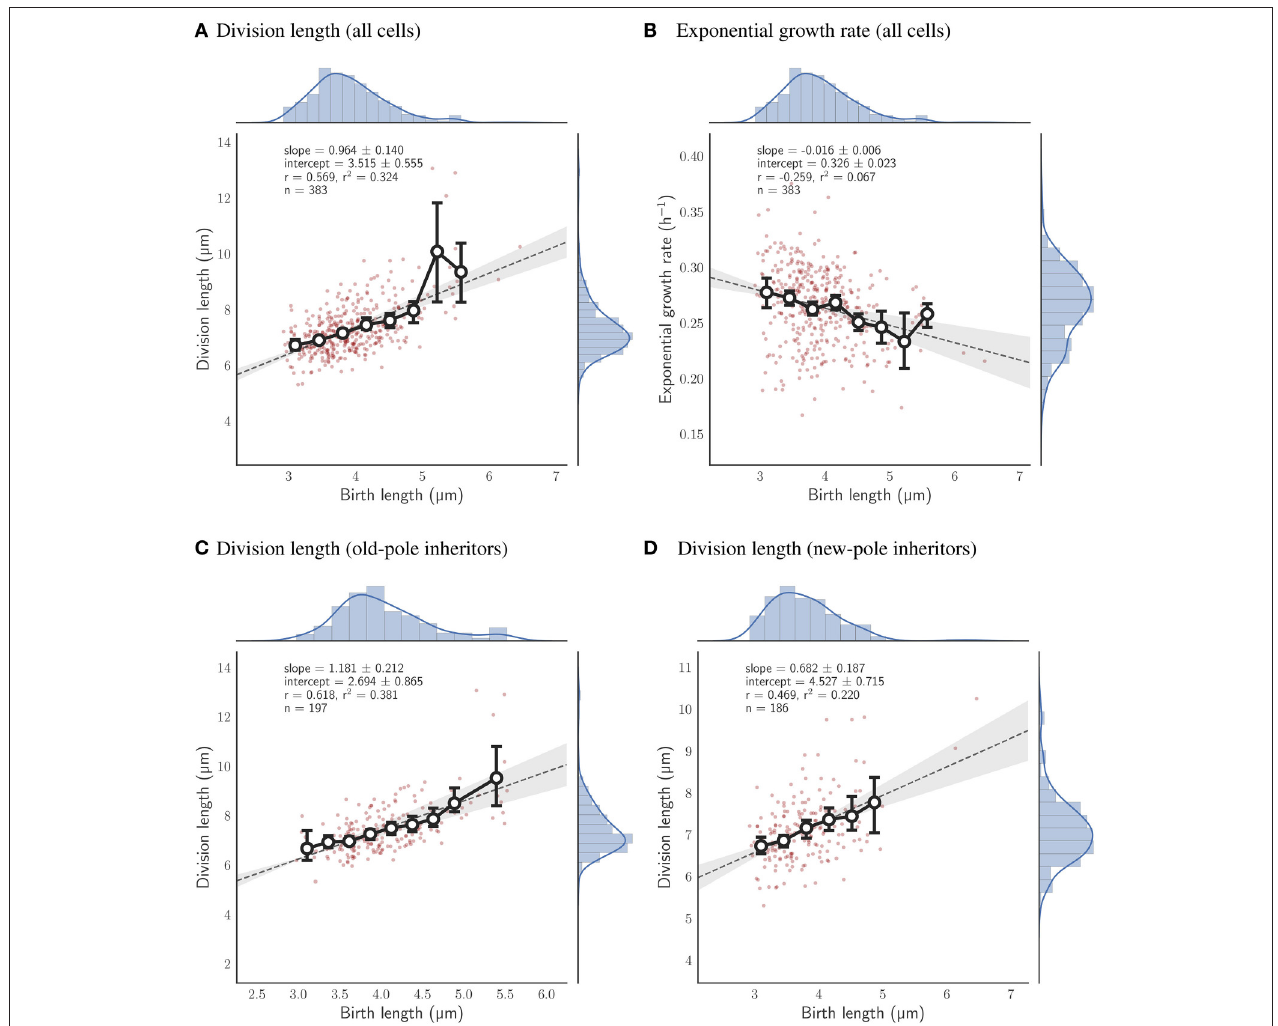
FIGURE 5 | Relationship between birth length and division length or exponential growth rate for cells grown with acetate as a sole carbon source. Colors and legends as for Figure 2 . (A) Relationship between birth length and division length for all cell divisions. (B) Relationship between birth length and exponential growth rate for all cell divisions. (C) Relationship between birth length and division length for cells which inherit the old-pole from their mother cell. (D) Relationship between birth length and division length for cells which inherit the new-pole from their mother